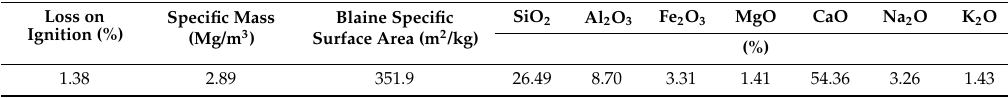
Table 3. Chemical composition and physical properties of